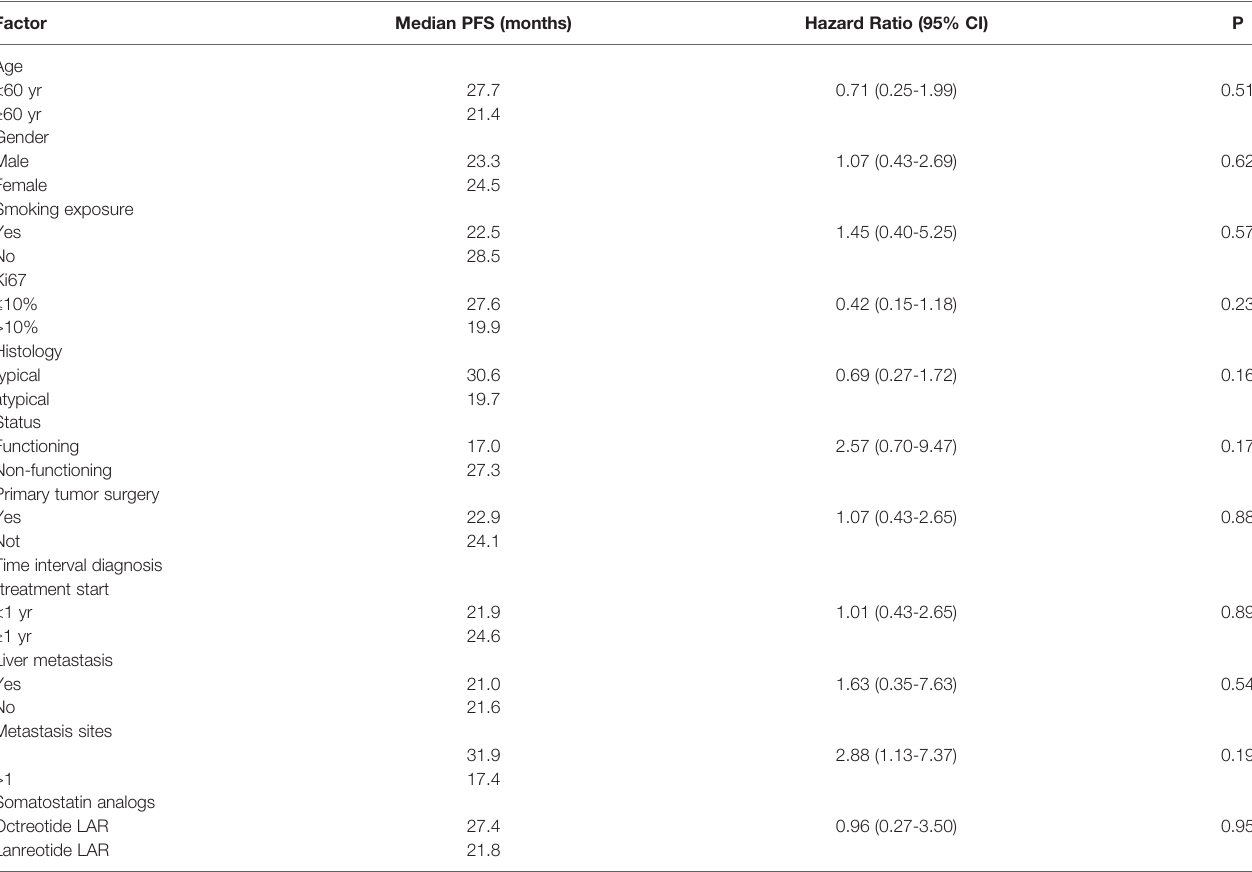
TABLE 2 | Studies data